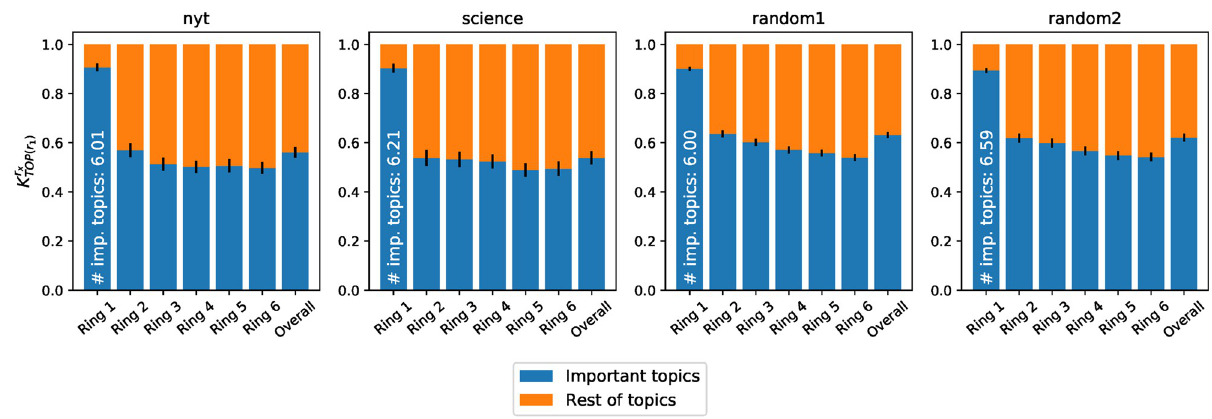
Fig 16. Average strength of ring #1’s important topics in the semantic profile of each ring and of the whole ego network. Each bar stands for the semantic profile of each ring (and overall ego network, in the last bar), where the blue part represents the share covered by the most important topics of ring #1 (their average number j U j is written in white). r 1